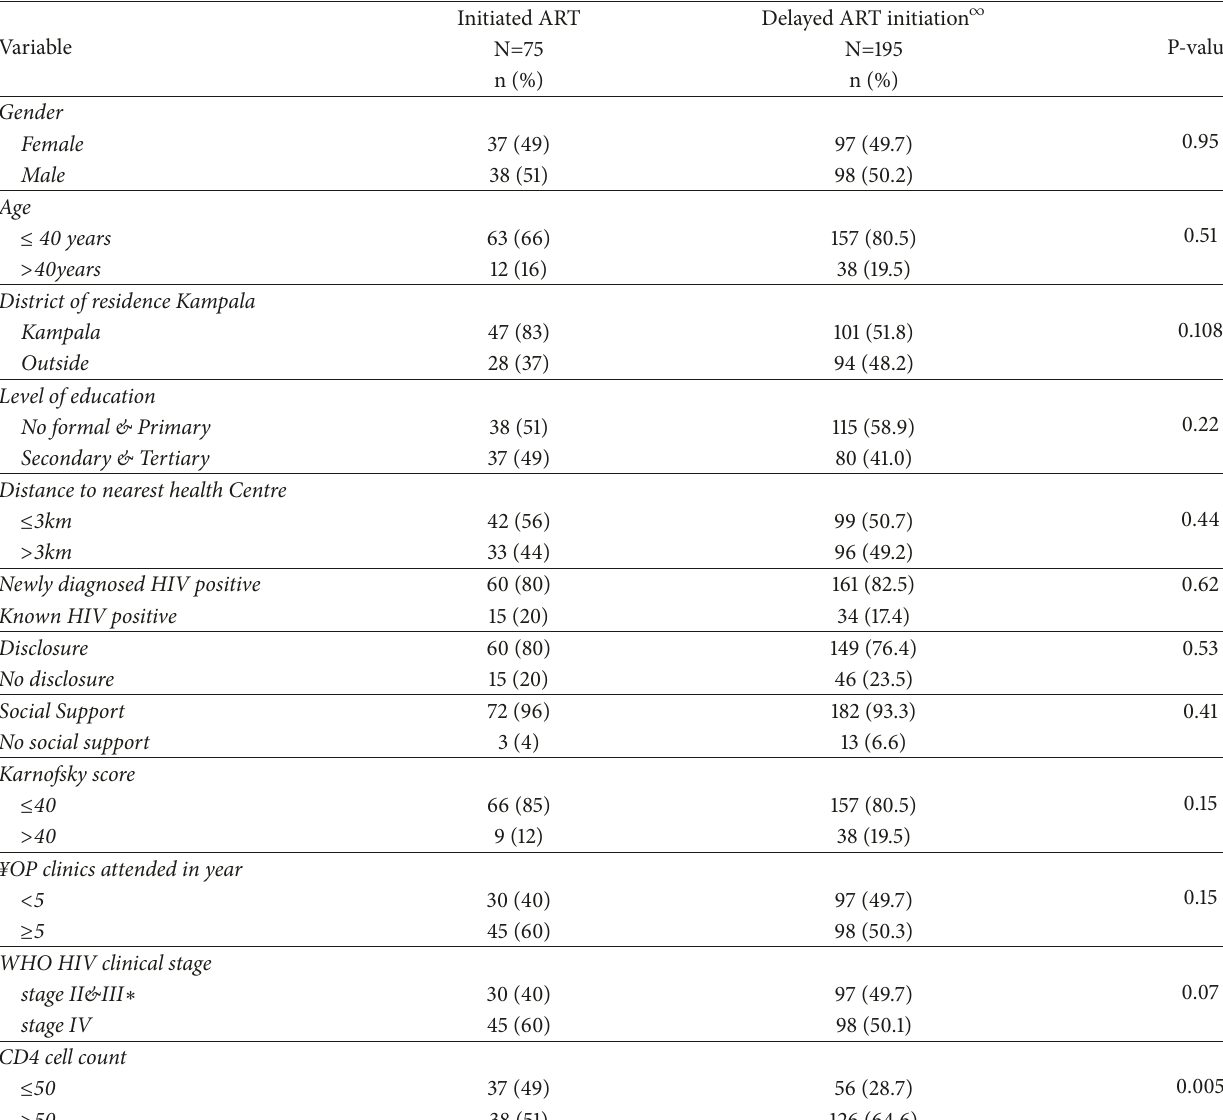
Table 1: Characteristics of HIV-infected adults hospitalized at Mulago hospital and their antiretroviral therapy (ART) initiation status within two weeks of